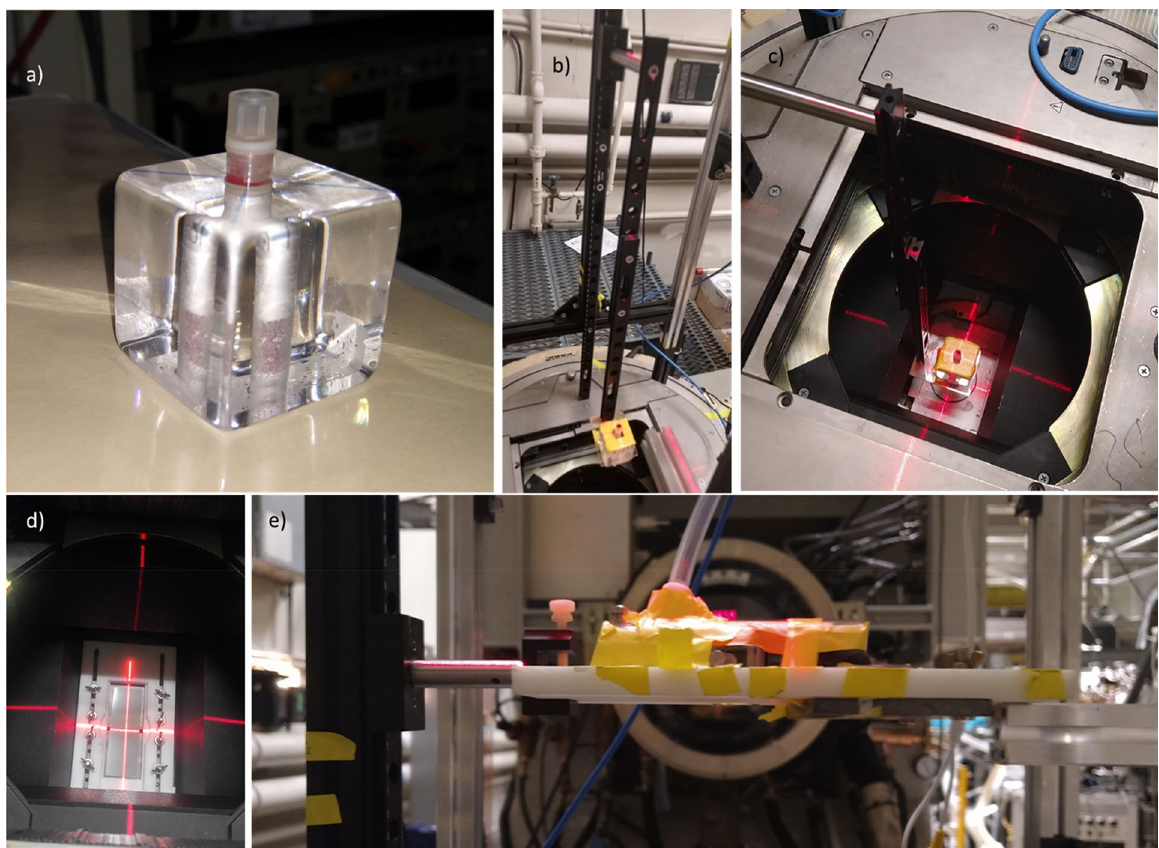
Figure 6. ( a ) Holder for matrix tube at an SSD of ( b ) 75 cm and ( c ) 20 cm. ( d ) shielded holder for mice. ( e ) shielded holder with anesthetized mouse being irradiated hemi-body at 10 Gy/s (SSD = 90